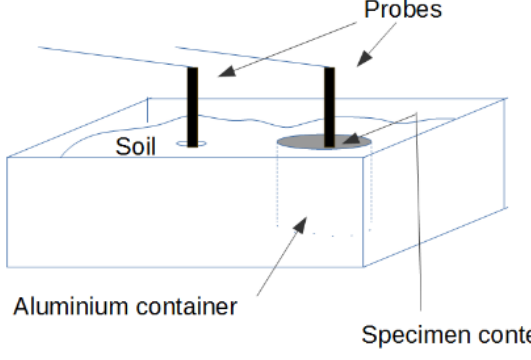
Figure 5. Schematic description of our experimental soil platform. Important realization note: the electrode must not be in contact with the aluminum